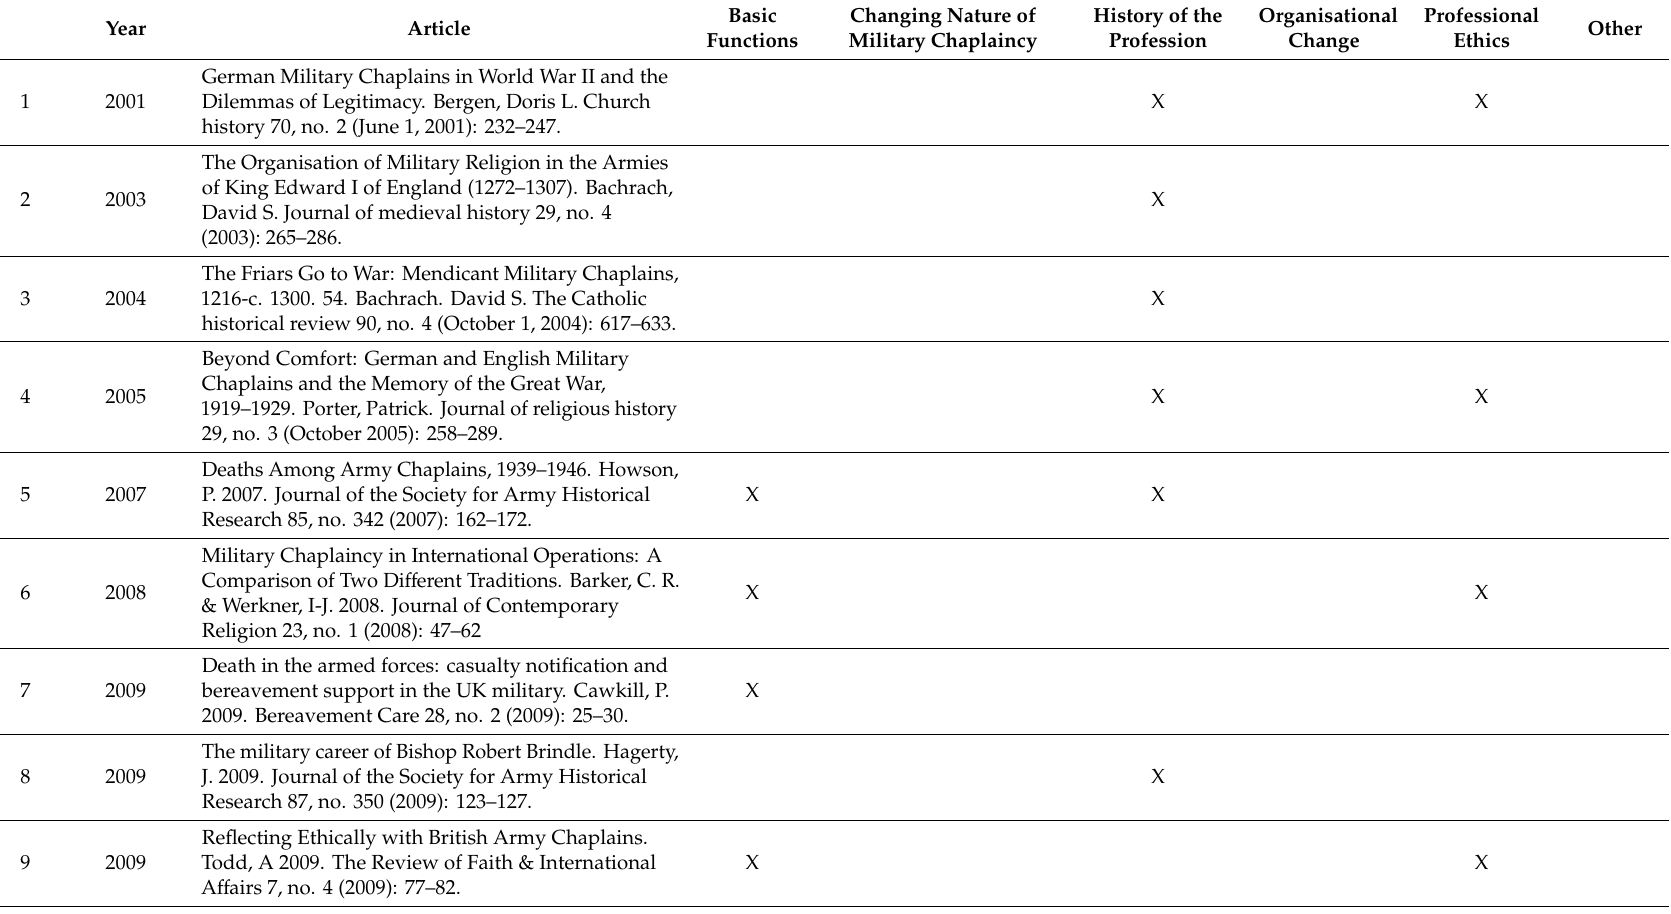
Table A1. The classification description of the European military chaplaincy articles between the years